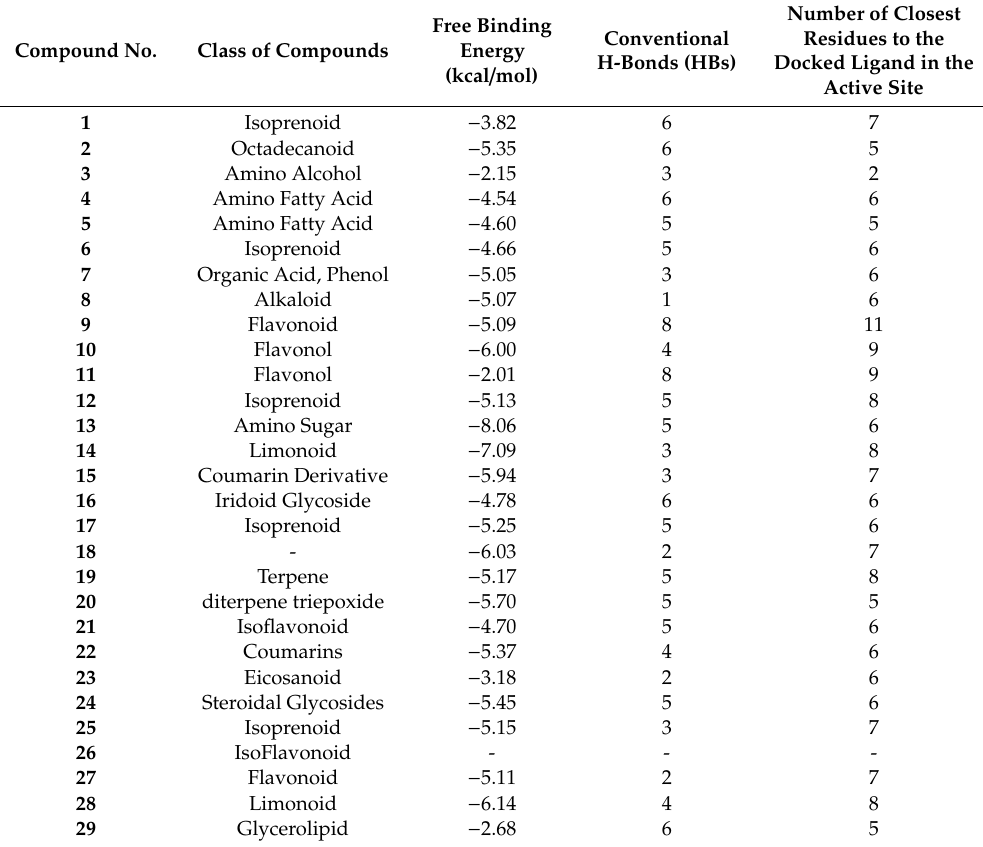
Number of Closest Free Binding Conventional Residues to the Energy H-Bonds (HBs) Docked Ligand in the (kcal / mol) Active